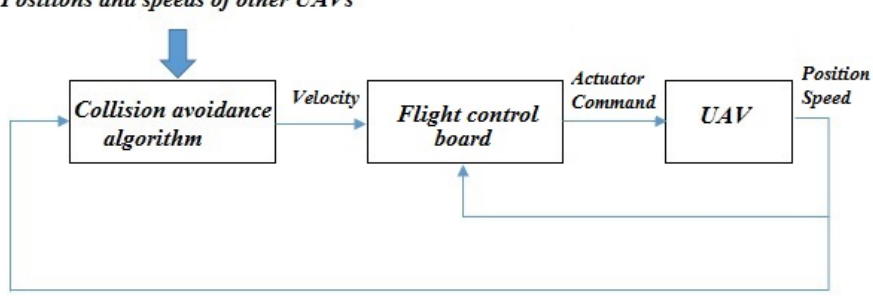
Figure 4. UAV control with collision avoidance